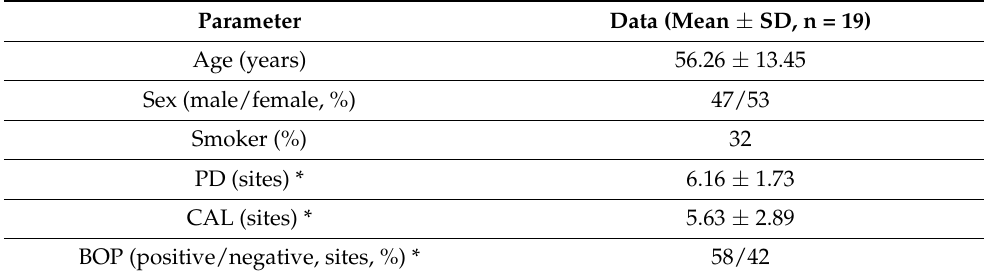
Table 3. Demographic data and clinical parameters of the participants of the